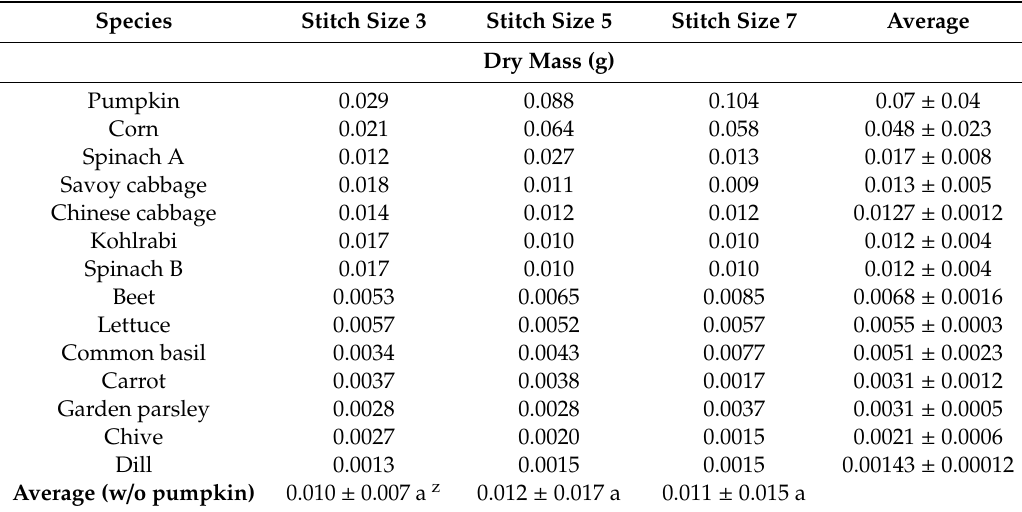
Table 5. Dry masses per seedling of shoots above the textile fabrics, sorted by the average dry